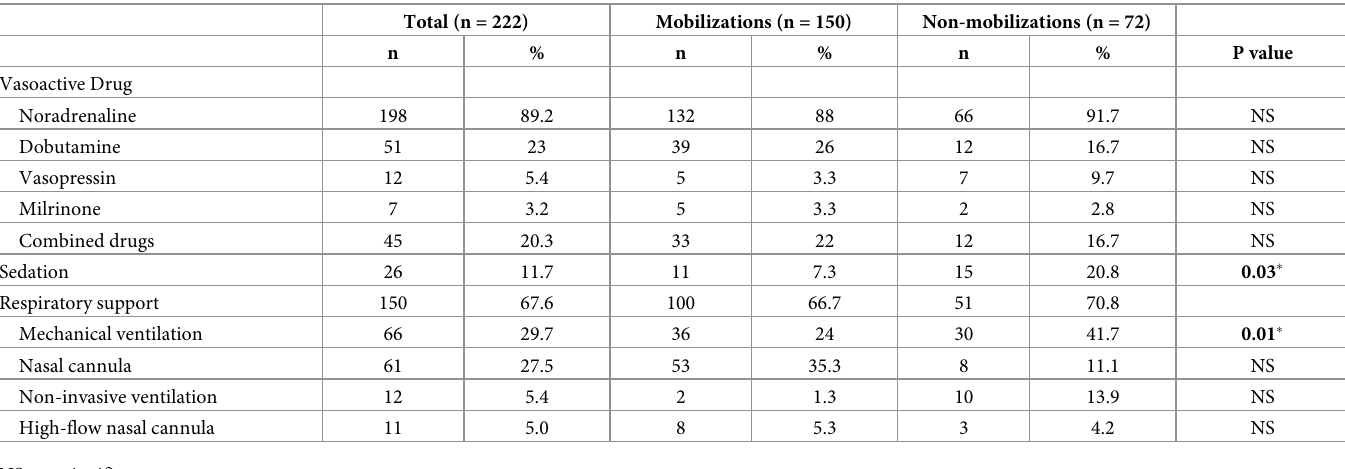
Table 2. Clinical support needs during mobilizations and non-mobilizations.